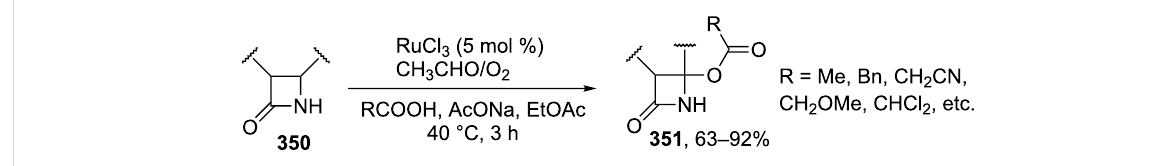
Scheme 79: Ruthenium chloride-catalyzed acyloxylation of β -lactams.